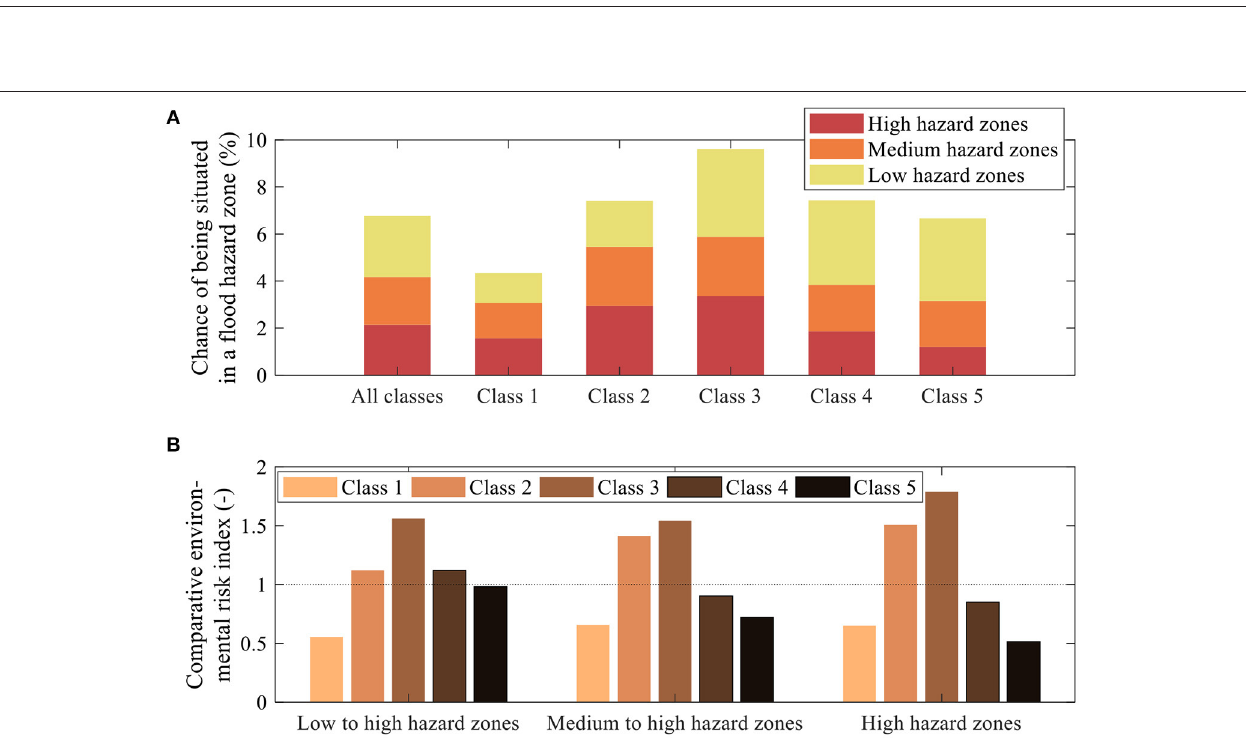
FIGURE 7 | (A) Chance for households of being situated in a particular flood hazard zone, as a function of their ISD class. (B) Comparative environmental risk index as a function of the level of hazard.